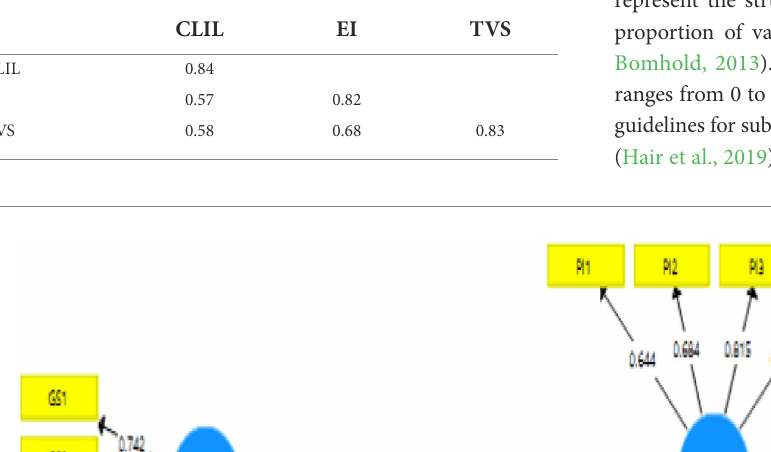
TABLE 3 Results of the discriminant